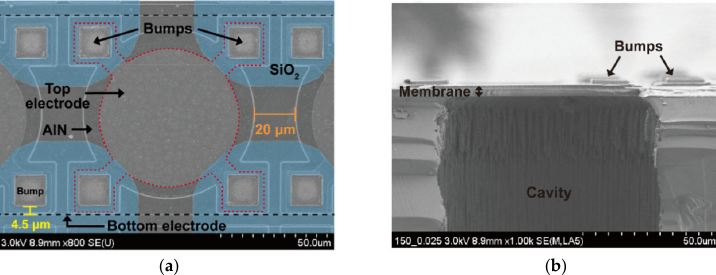
Figure 5. Scanning electron microscope images of the fabricated AlN pMUT array. ( a ) Top view and ( b ) cross-sectional view.